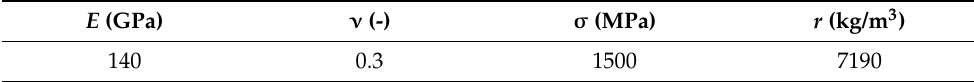
Table 2. Key parameters of the Cr